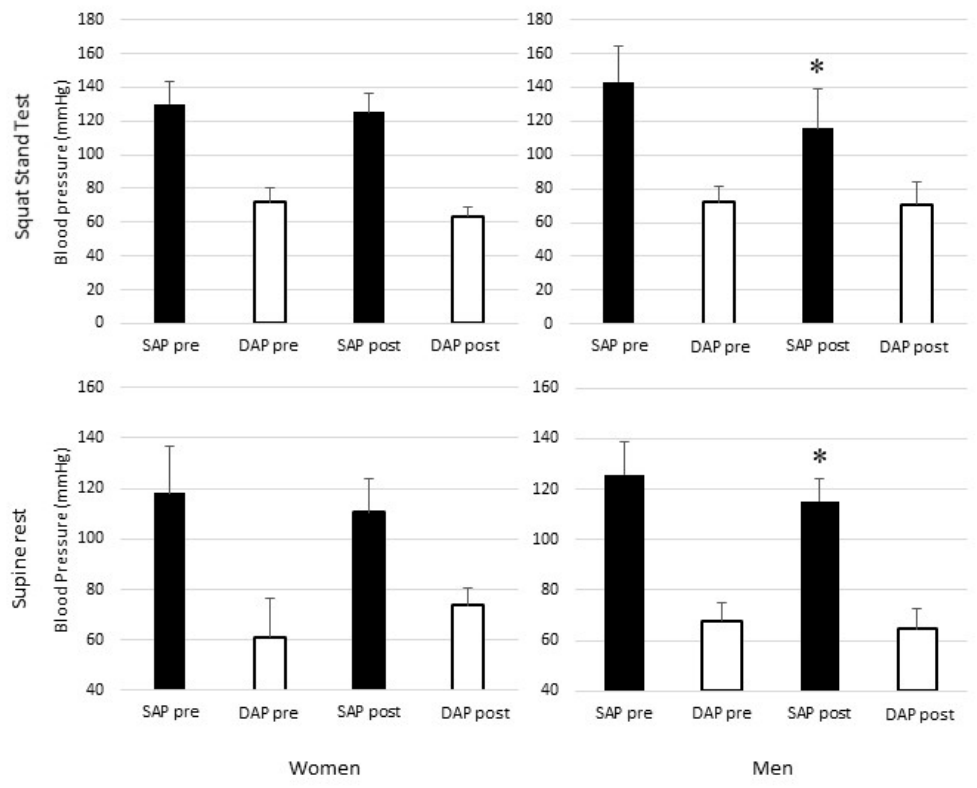
Figure 1. Mean ± SD Systolic (SAP; black bars) and diastolic (DAP; white bars) blood pressures before (Pre) and after (Post) the 21-km run in men ( left panels) and women ( right panels) in supine position ( up panels) and during the squat stand test ( bottom panels). SAP = systolic arterial blood pressure, DAP = diastolic arterial blood pressure; pre = before the half-marathon run; post = after the half-marathon run; * = significantly different from pre.